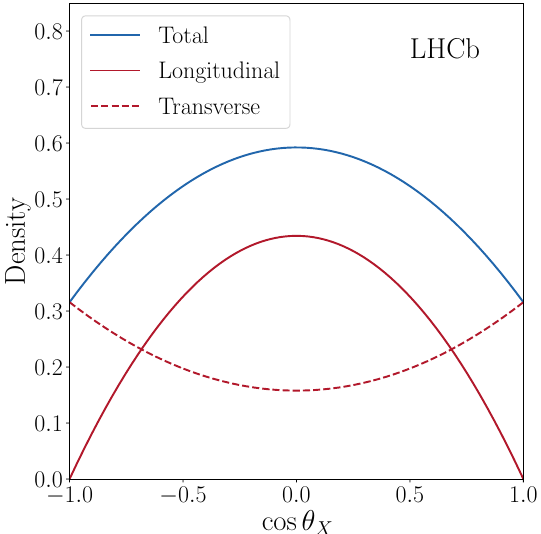
Figure 8 . Transverse and longitudinal contributions to the one-dimensional decay rate shown as a function of cos θ . X